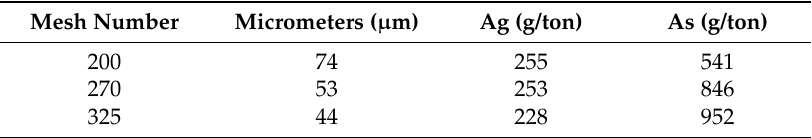
Table 2. Ag and As content in Zn concentrate per mesh.